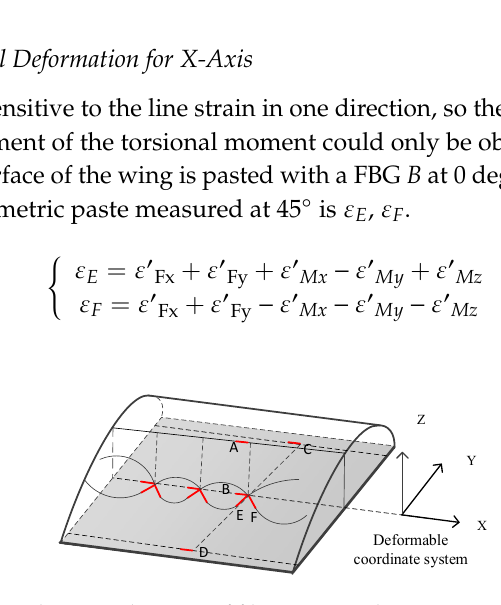
Figure 6. Schematic diagram of fiber grating shear strain measurement.